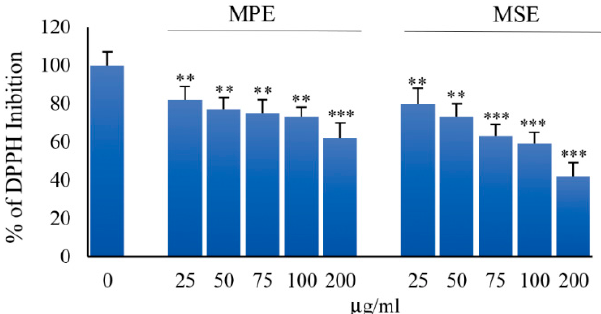
Figure 1. MPE and MSE possess radical scavenging activity. The antioxidant activity of MPE and MSE was evaluated by DPPH (1,1-diphenyl-2-picrylhydrazyl) radical scavenging assay. Different concentrations of MPE and MSE (25–200 µ g/mL) were added on ethanol DPPH • solution and absorbance of each concentration was measured at 517 nm by spectrophotometer. The bar graphs represent the mean of three independent experiments ± SD. ** p < 0.01 and *** p < 0.001 with respect to the only vehicle control.